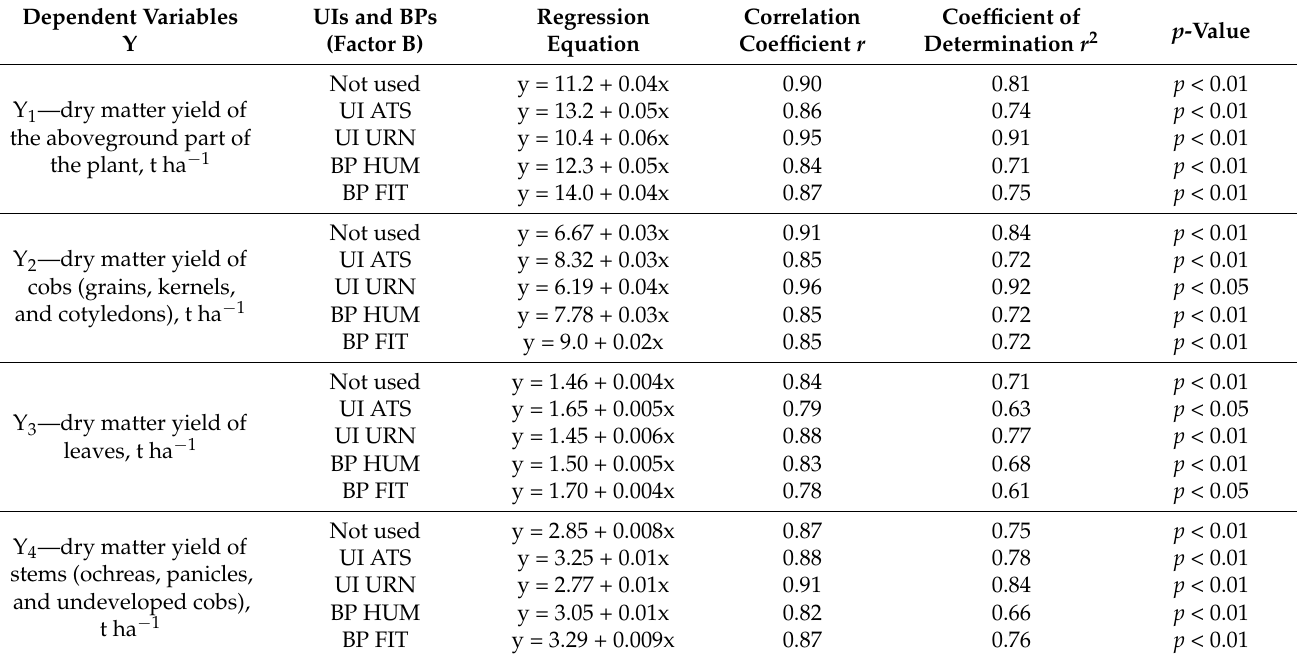
Table 11. Dependence of maize productivity on nitrogen fertilizer rates (Factor A: x—kg ha − 1